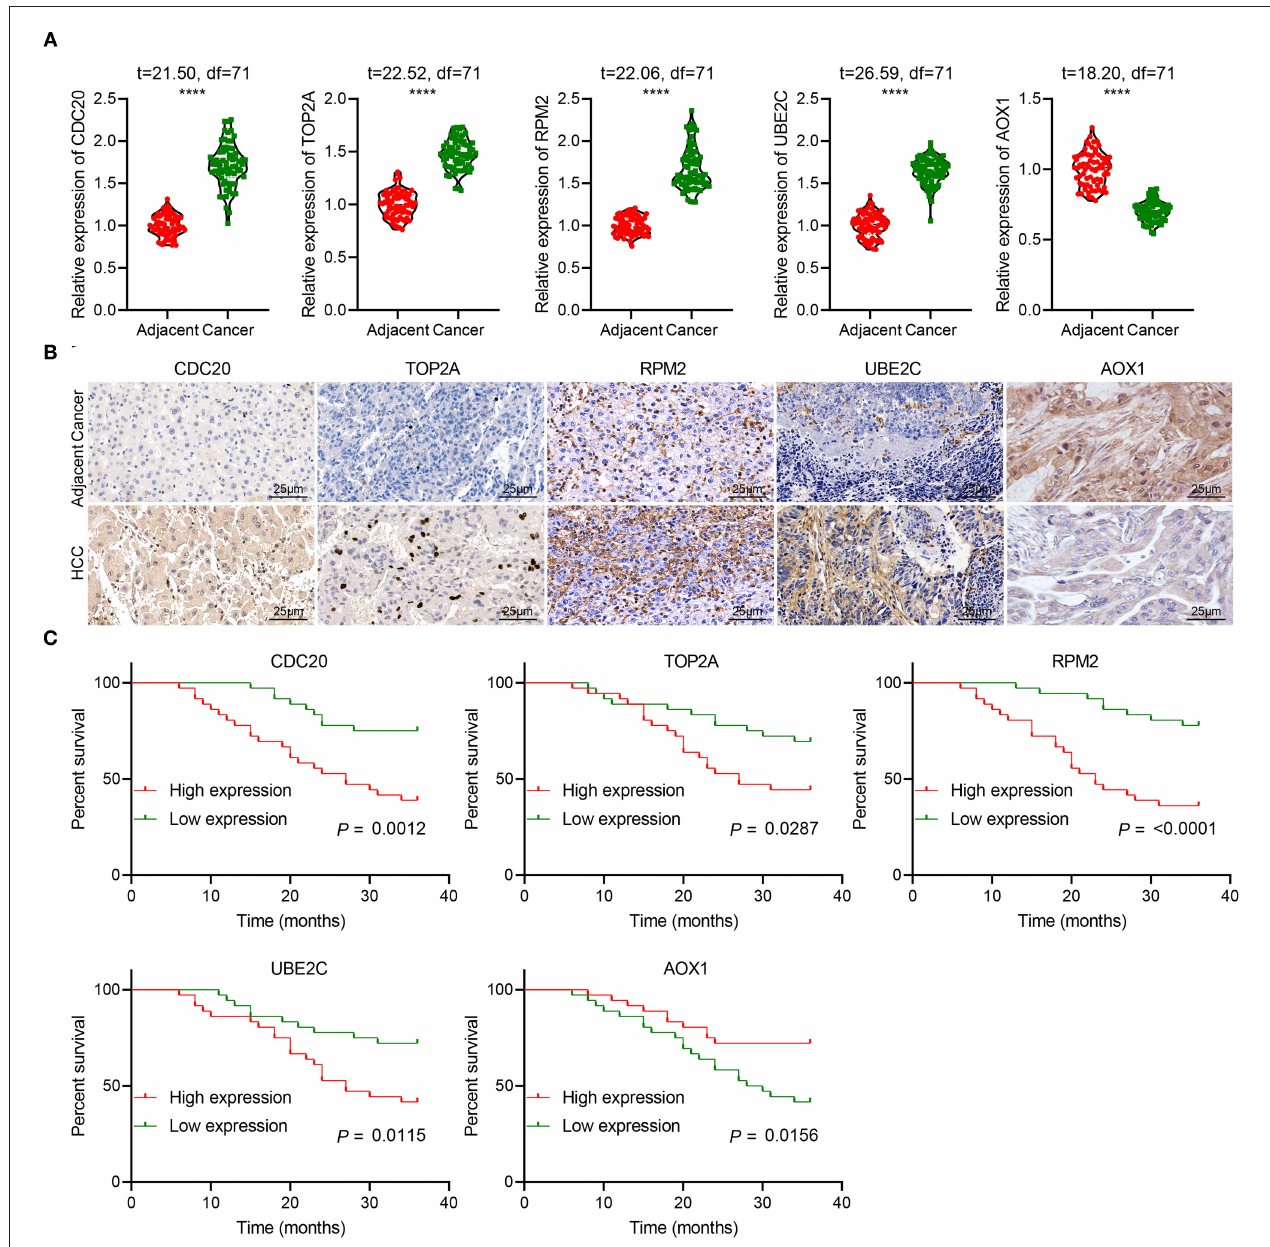
FIGURE 11 | The clinical significance of five key genes in patients with HCC. (A) , RT-qPCR detection of CDC20, TOP2A, RRM2, UBE2C and AOX1 expression in the cancer and adjacent normal tissues from 72 HCC patients. (B) , Immunohistochemistry analysis of CDC20, TOP2A, RRM2, UBE2C and AOX1 proteins in the cancer and adjacent normal tissues from 72 HCC patients (400 × ). n = 10. (C) , Kaplan-Meier analysis of the relationship between the expression of 5 key genes and the prognosis of 72 patients with HCC. The X-axis represents survival time (months), and the Y-axis represents survival rate. **** p <